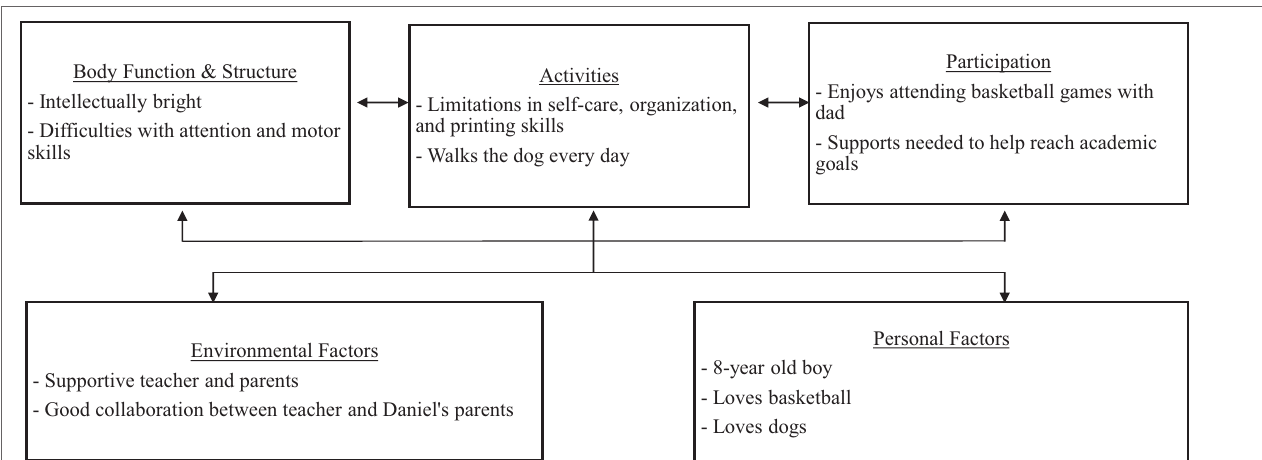
Adapted from “ How to use the ICF: A practical manual for using the International Classification of Functioning, Disability and Health (ICF). Exposure draft for comment (Box 1: The ICF Model: Interaction between ICF components, p. 7). October 2013. Geneva: World Health Organization. Adapted with the permission of the World Health Organization. FiGUre 1 | Classification of Daniel’s case study using the ICF framework. Adapted from World Health Organization (2013) (Box 1: the ICF model: interaction between ICF components, p. 7). Adapted with the permission of the World Health